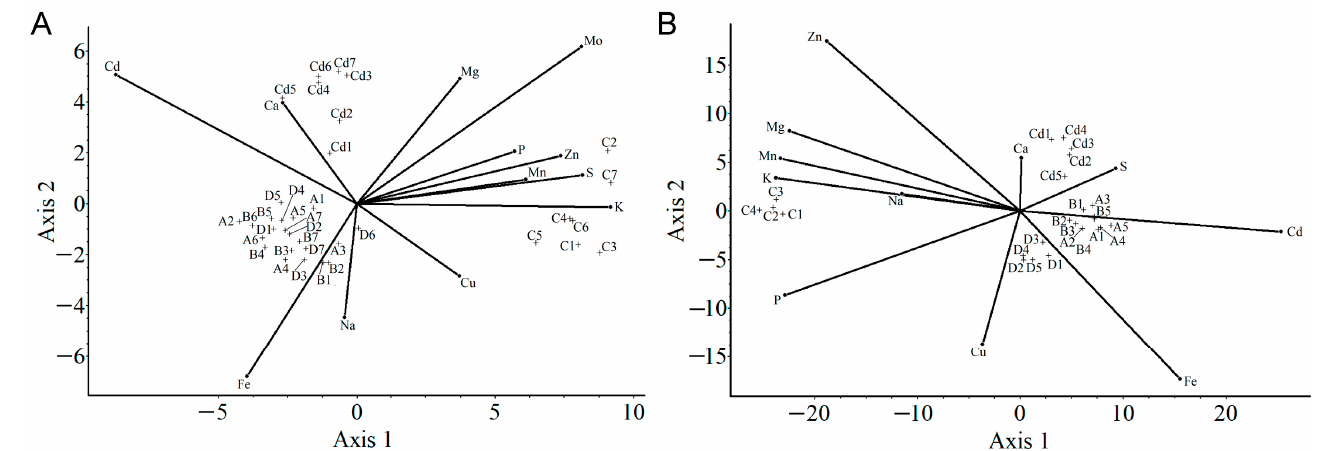
Figure 6. Canonical analysis of variance of mineral uptake pattern in shoot ( A ) and root ( B ) samples of Szarvasi-1 energy grass in different treatments. C, Cd, A, B, and D refer to Ctrl, Cd-treated, 0.02SMM+Cd, 0.05SMM+Cd and 0.1SMM+Cd groups.